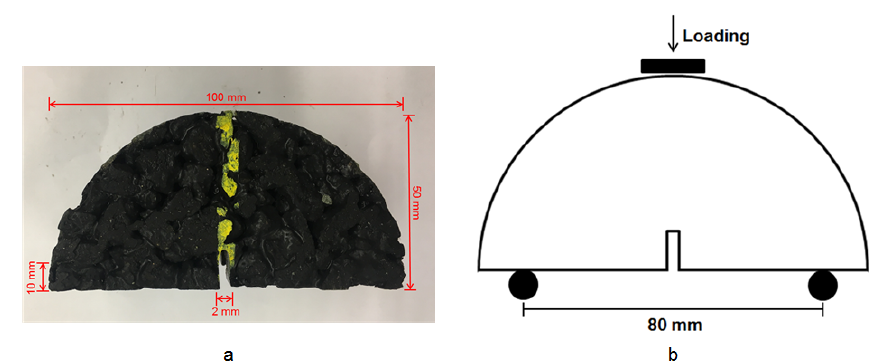
Figure 1. (a) SCB testing specimen; (b) loading on SCB samples.